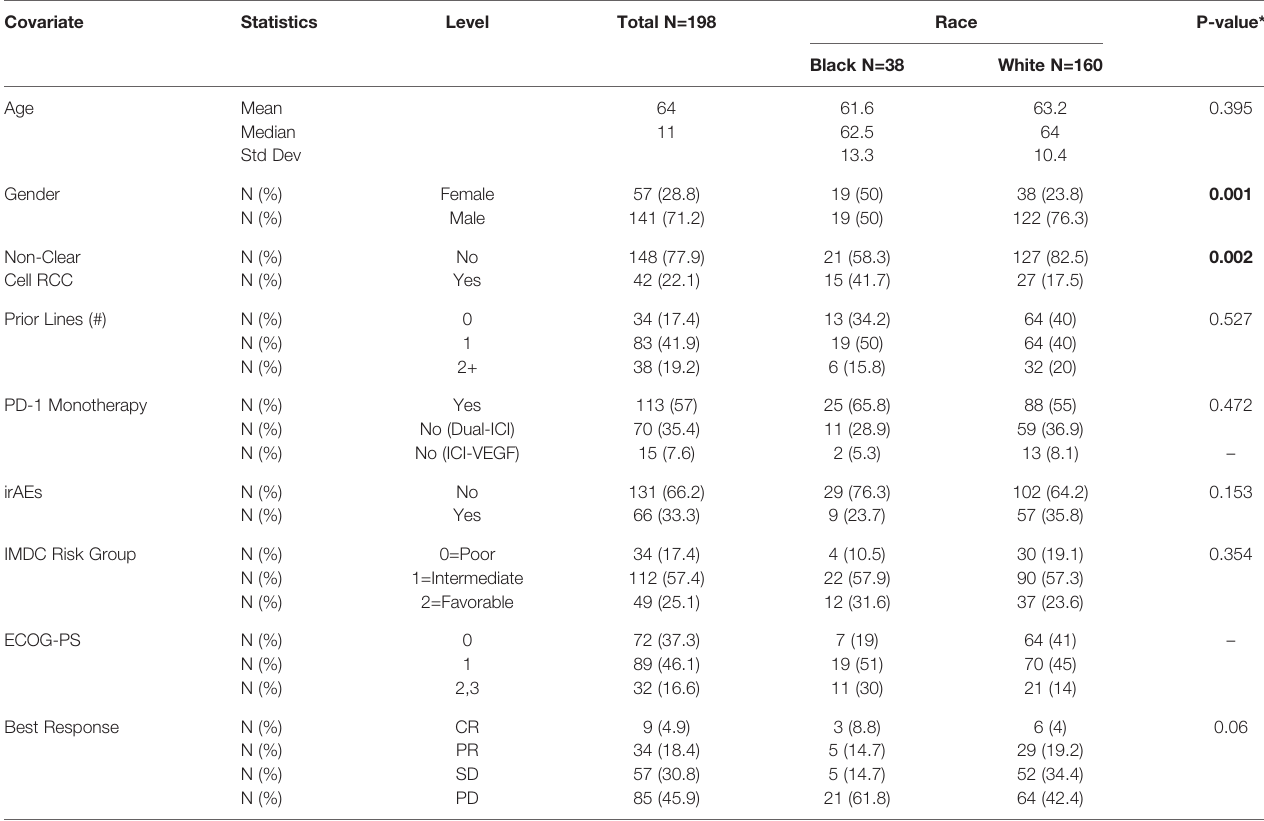
TABLE 1 | Baseline Demographic and Clinical Characteristics of Patients with metastatic RCC by Race.